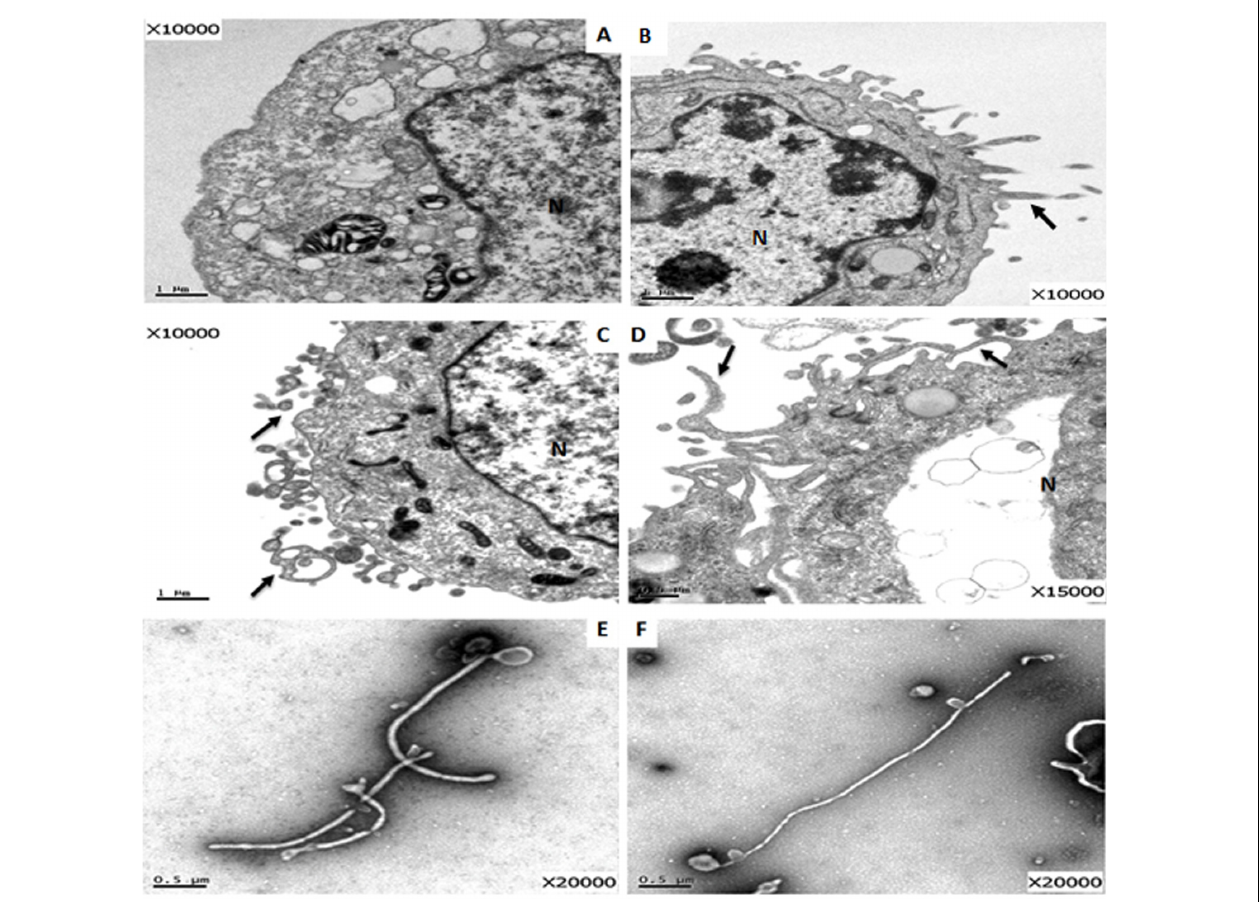
FIGURE 2 | TEM analysis of the EBOV VLP assembly in DREP-based GP and VP40 transfected cells. (A–D) TEM analysis of ultrathin sections of cells: (A) 293 cells control; (B) 293 cells transfected with DREP-VP40 for 48 h; (C) 293 cells transfected with DREP-GP for 48 h; (D) 293 cells co-transfected with DREP-GP and DREP-VP40 for 48 h; (E) and (F) the concentrated preparations from the supernatant of cells co-transfected with DREP-GP and DREP-VP40 for 48 h. “N” represents the cell nucleus. The black arrow indicates the assembly of